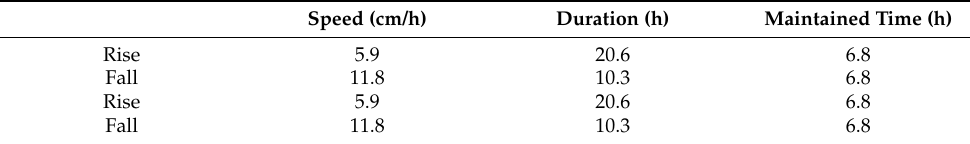
Table 2. Experimental changes in water level over time.